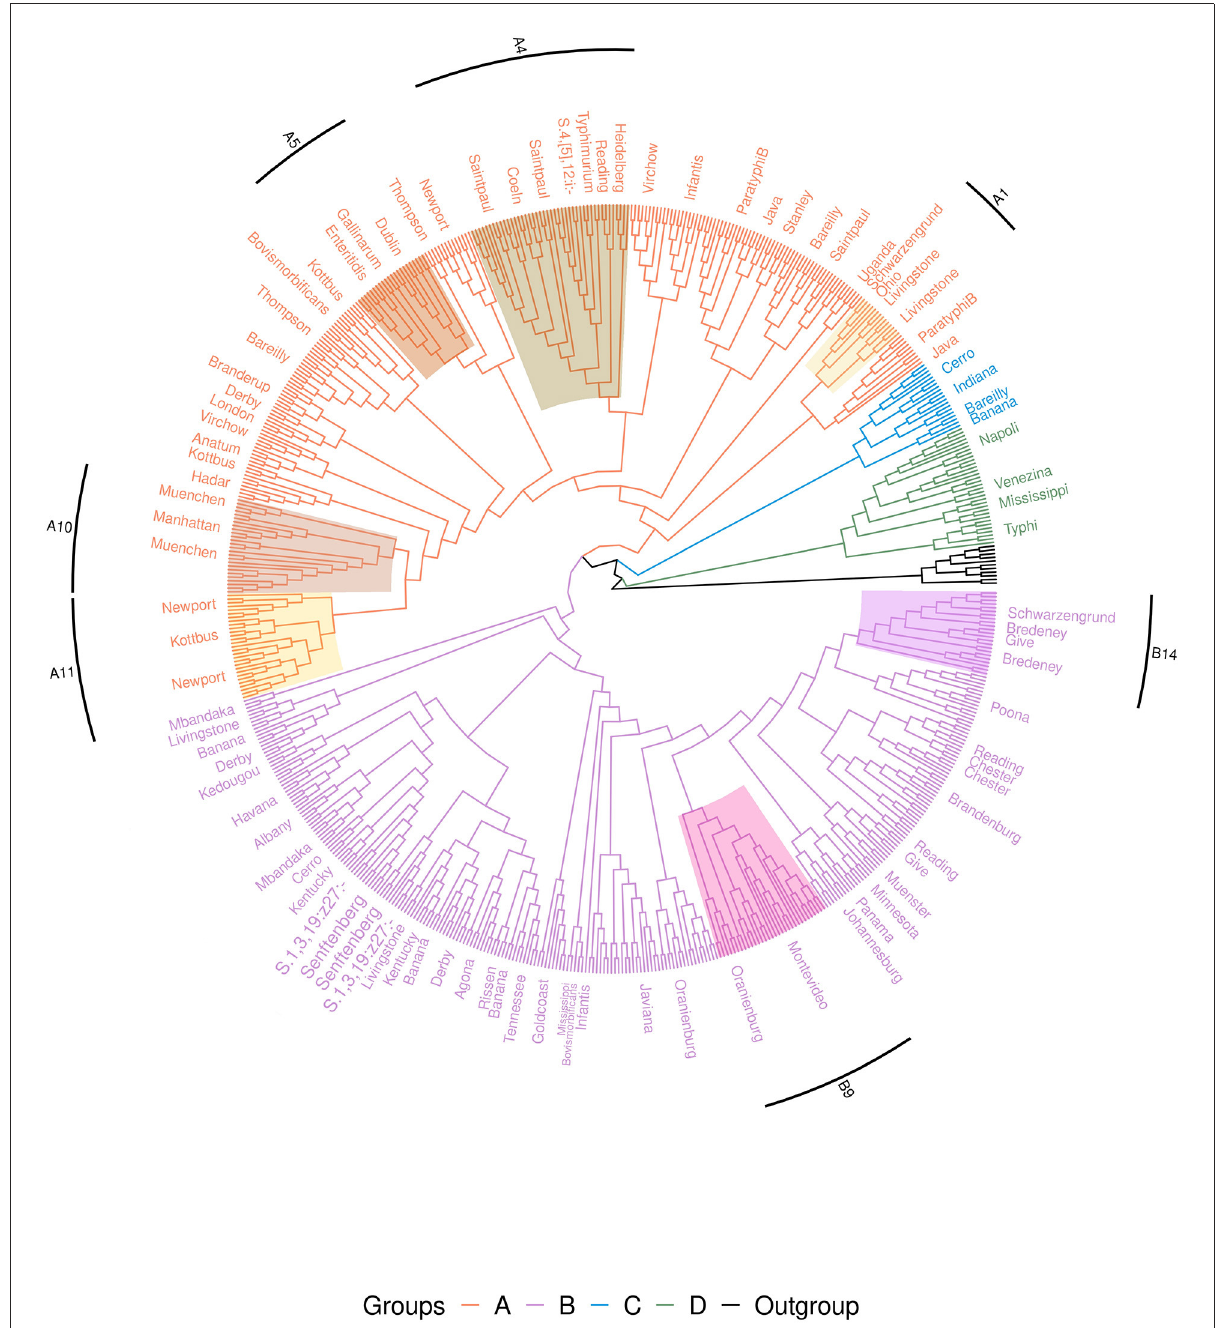
FIGURE2 Phylogenetic cgMLST distance tree of the 650 genome set of Salmonella . The tree is rooted on the Salmonella entrerica subsp. arizonae , diarizonae , houtenae , indica and salamae genomes. For better visualization of the groups, the tree is shown without branch lengths. Branches are colored to distinguish the four groups. Due to the high number of strains in the tree, strain labels are not shown and serovars are indicated along corresponding branches. Strongly supported subgroups are shaded in different colors (for the description of these subgroups see also Figure 3 and Table